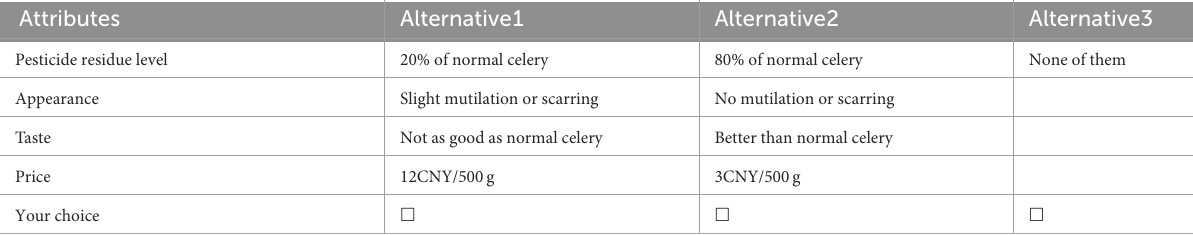
TABLE 2 Example of discrete experiment choice set.